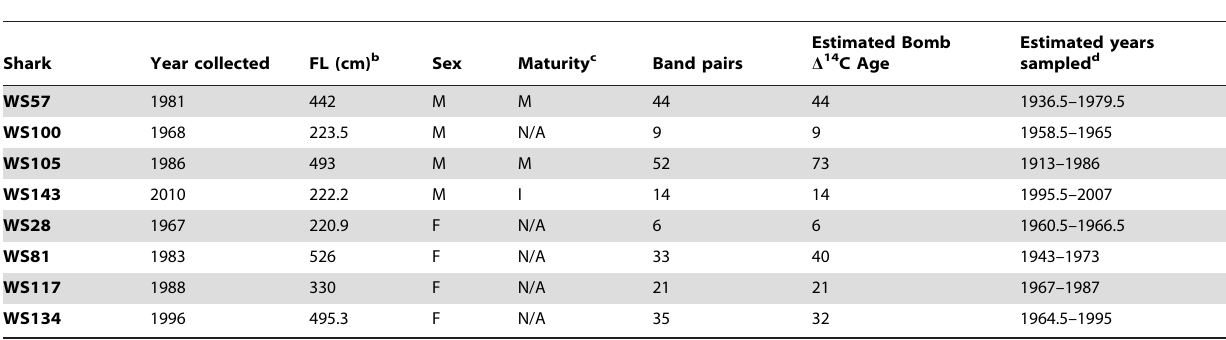
Table 1. Collection and sampling information for individual sharks.